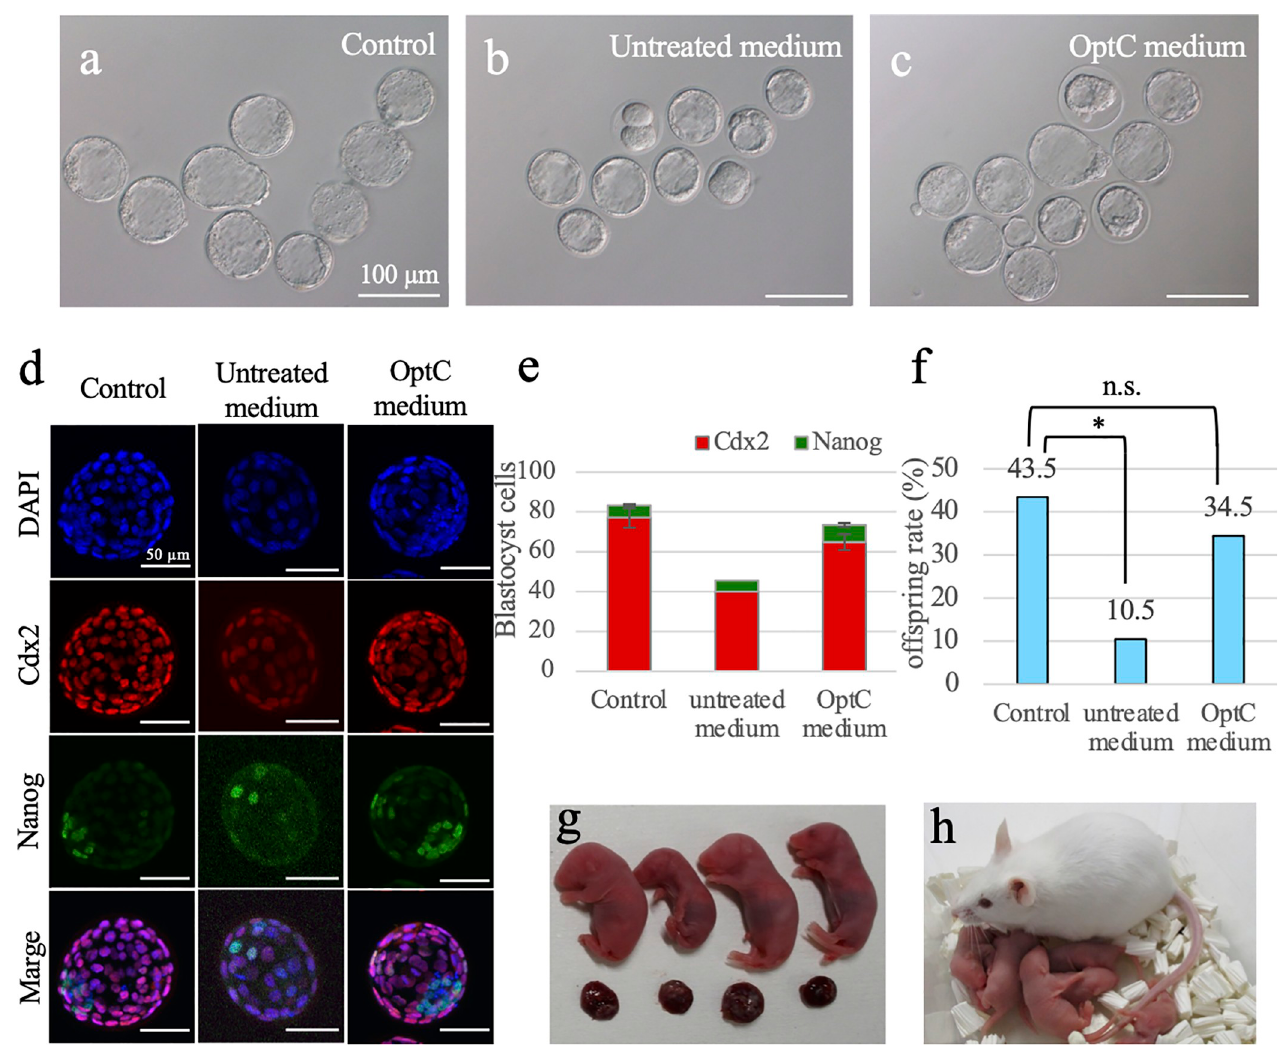
Fig 2. Embryo culture in a sealed plastic tube using OptC medium. (a–c) Blastocysts derived from conventional culture method (Control) (a), just warmed CZB medium in a sealed tube (untreated medium) (b), and this system (OptC medium) (c). (d) Blastocysts derived from control, untreated CZB medium with sealed tube and OptC medium with sealed tube were immunostained to measure inner cell mass (ICM) and trophectoderm (TE) cell numbers. Blue: DNA (DAPI); red: TE cell (Cdx2) and green: ICM cell (Nanog). (e) The number of Cdx2-positive (red) or Nanog-positive (green) cells. (f) The birth rate of offspring after transferred blastocysts derived from control, untreated CZB medium with sealed tube or OptC medium with sealed tube. (g) Live and healthy offspring derived from embryos cultured using OptC medium. (h) offspring obtained from OptC medium grew well and bred to the next generation.